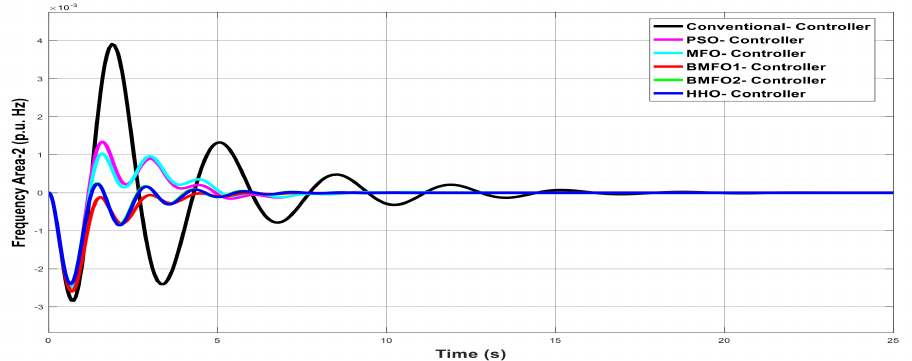
Figure 4. Dynamic response of Area2 frequency with various controllers under unilateral